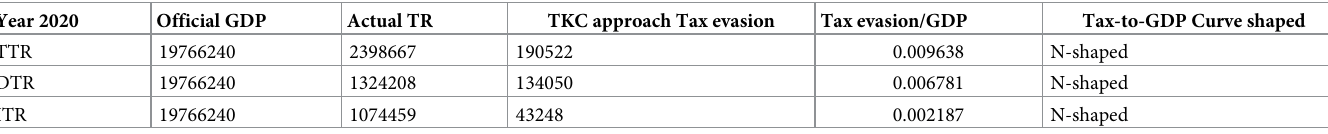
Table 6. Estimation of Tax Kuznets curve of